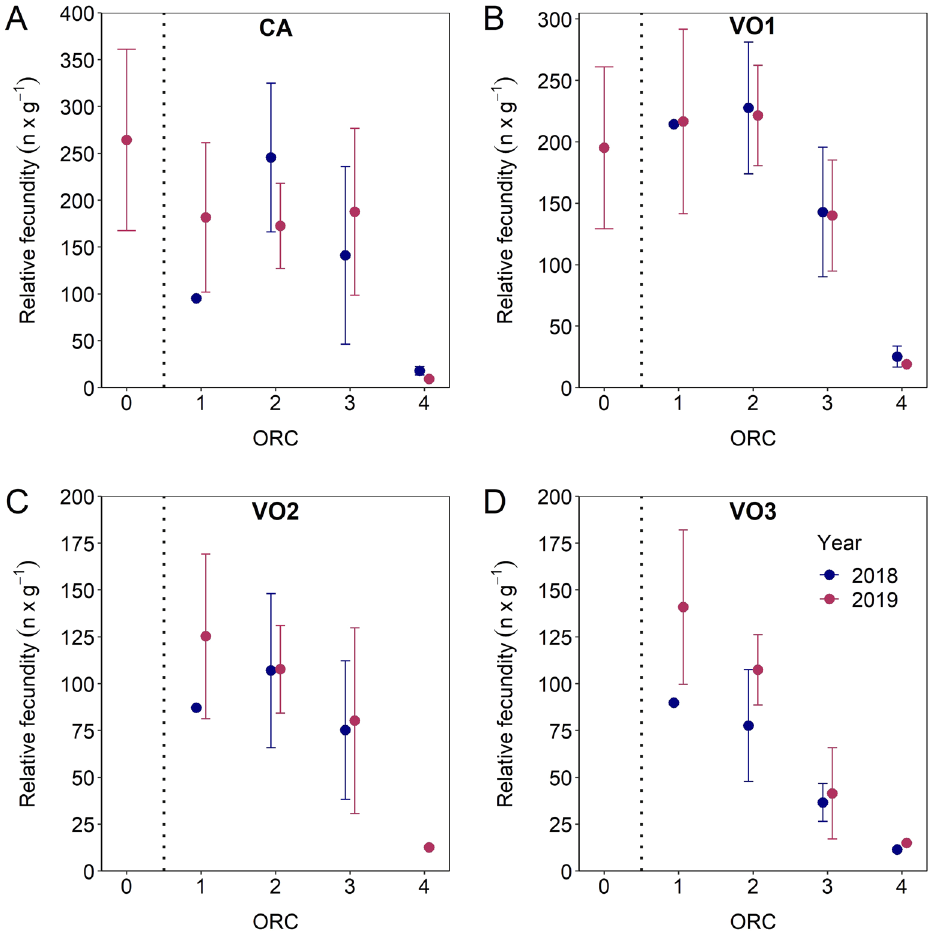
Figure 8. Mean (± 95% confidence interval) relative fecundity of cortical alveoli oocytes (CA) and vitellogenic oocytes (VO1-3) by oocyte ratio category (ORC) split by 2018 and 2019. Vertical line separates prespawning individuals (ORC0) from those that have already started spawning (ORC1 to 4). Note that the y-axis scale differs between